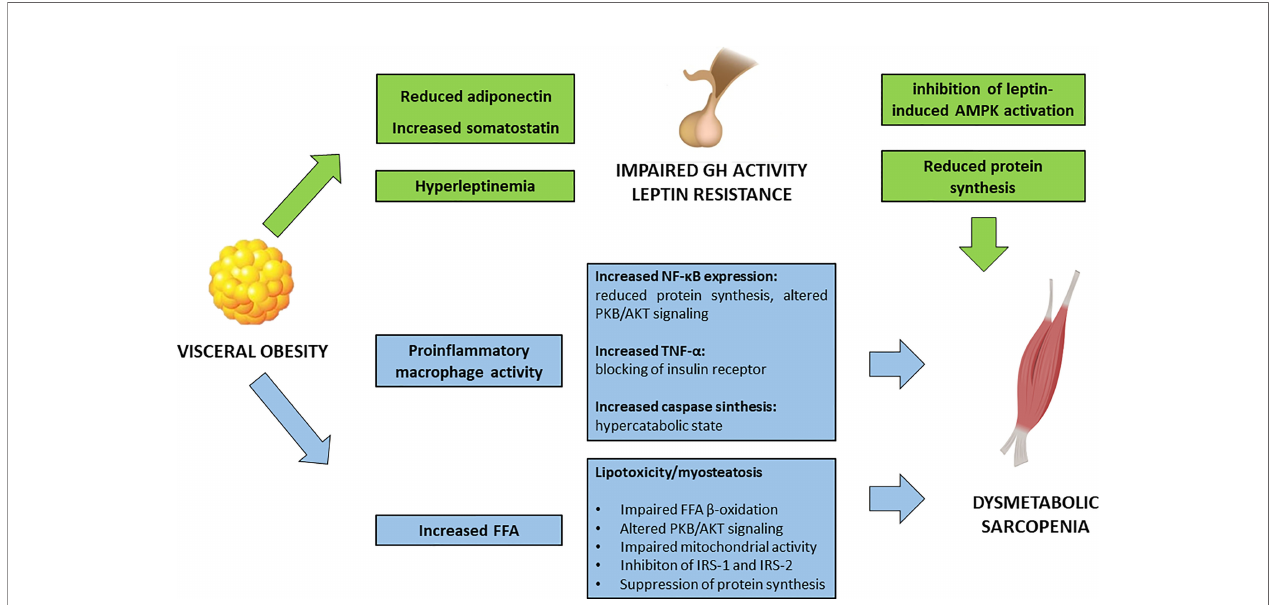
FIGURE 1 | Impact of visceral obesity on sarcopenia. FFA, free fatty acids; GH, growth hormone; IRS, insulin receptor substrates; NF- k B, Nuclear Factor – k B; PKB/AKT, Protein kinase B/AKT; TNF- a , Tumor Necrosis Factor – a